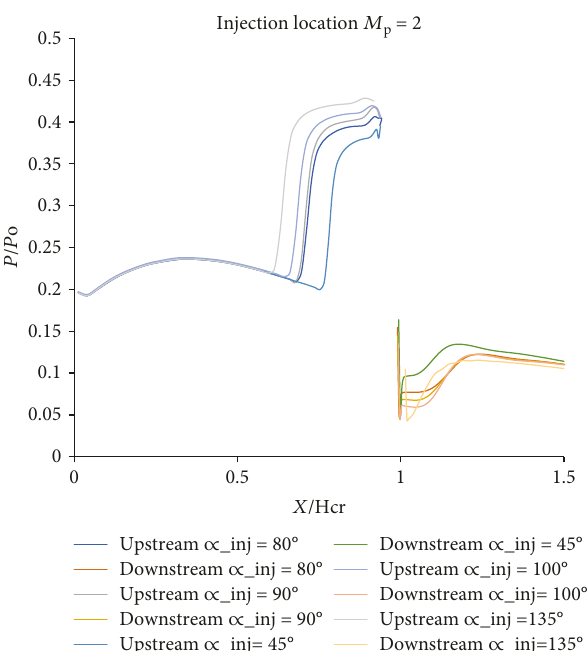
Figure 17: In fl uence of the injection angle on the static pressure distribution along the injector wall M